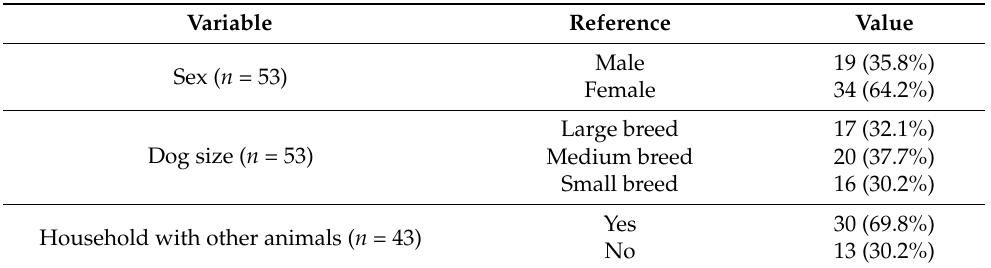
Table 1. Clinical, epidemiological, and laboratory variables of dogs admitted to the Intensive Care Unit of the Veterinary Hospital of the Federal University of Minas